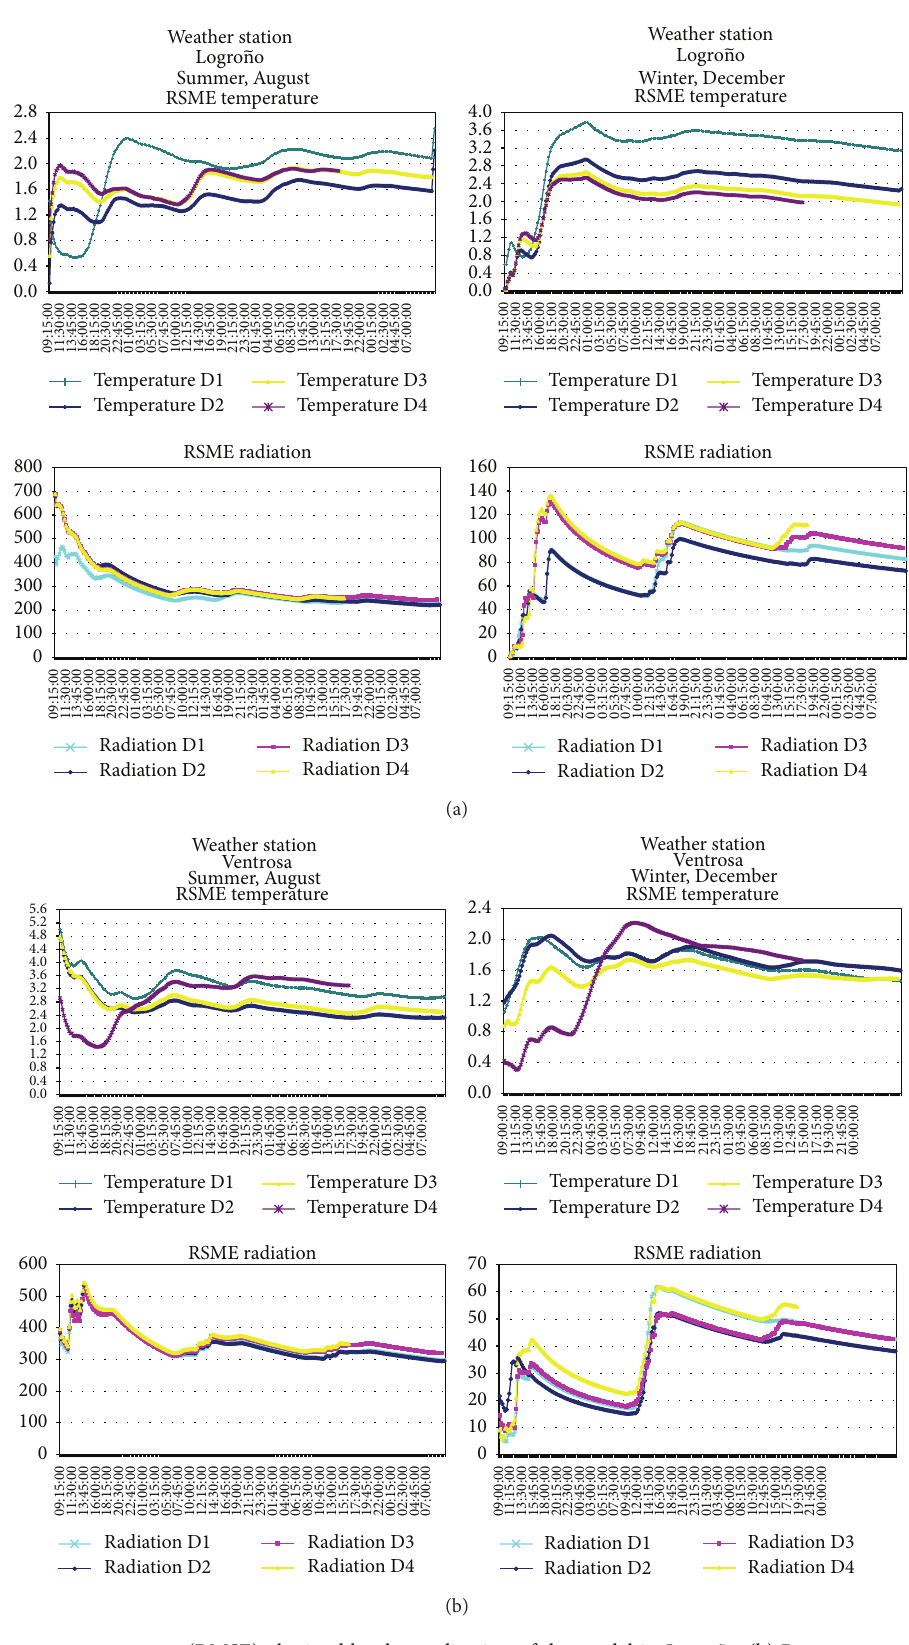
Figure 6: (a) Root mean square error (RMSE) obtained by the application of the model in Logro˜no . (b) Root means square error (RMSE) obtained from the application of the model in